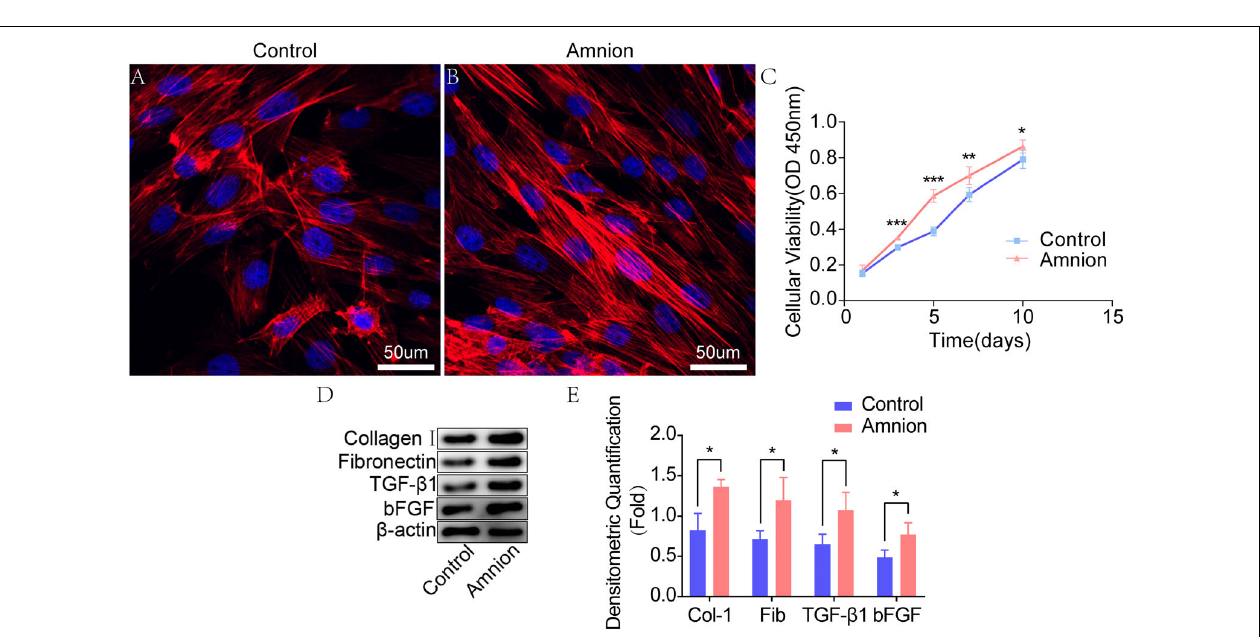
FIGURE 2 | Fluorescence images of tenocytes after 5 days of culture on the surface of a culture plate (control group) and acellular amniotic membrane (amnion group). Tenocytes presented a clear cytoskeleton, good biocompatibility with acellular amniotic membrane, and even distribution on the surface of the materials, showing better growth activity than the control group (A,B) . Cell viability was measured by CCK-8, and the proliferation curve of tenocytes in the control and amniotic membrane groups was drawn (C) . Western blot assay for collagen I, fibronectin, TGF- β 1, and bFGF expression in the tenocytes of the control and amnion groups for 1 week (D,E) . * p < 0.05; ** p < 0.01; and *** p <